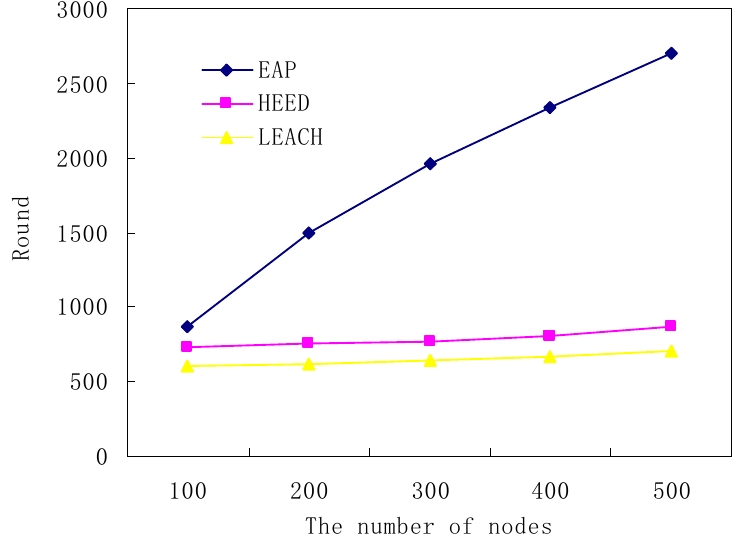
Figure 9. The number of nodes vs. network lifetime (expected QoS = 0.95).